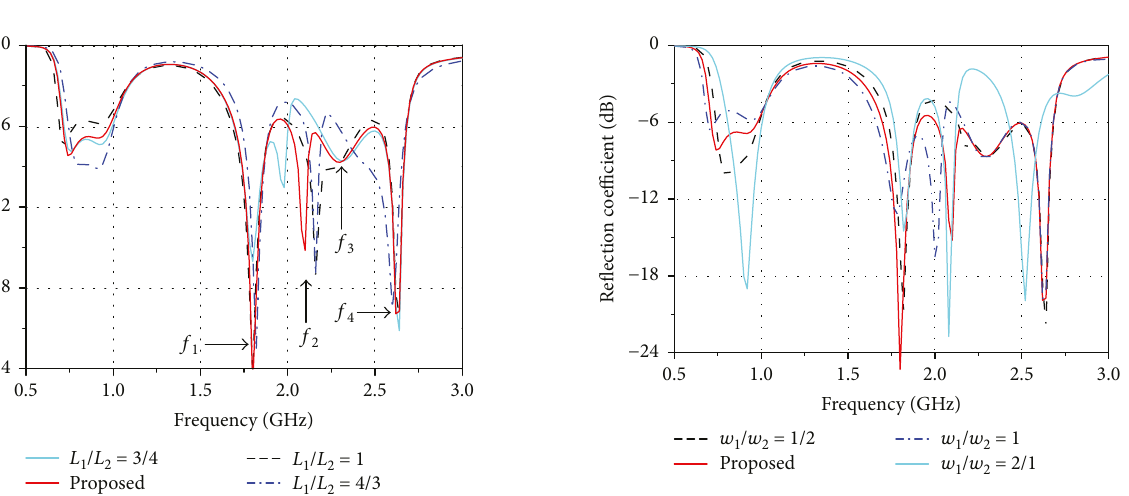
Figure 3: Simulated re fl ection coe ffi cient for the proposed antenna as a function of the ratio between L